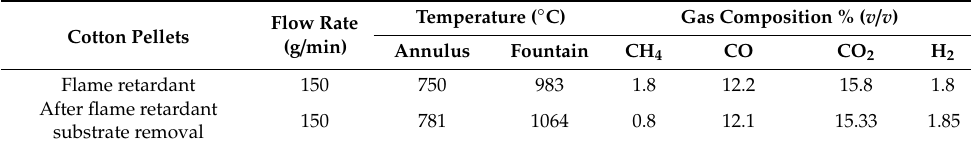
Table 2. Averaged gas composition values evolved from the